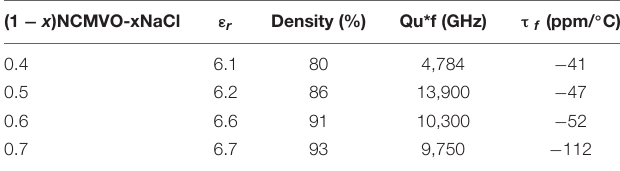
TABLE 2 | Variations of relative permittivity, quality factor and temperature coefficient of resonant frequency of (1 − x )NCMVO-xNaCl composites at 200 ◦ C, 50